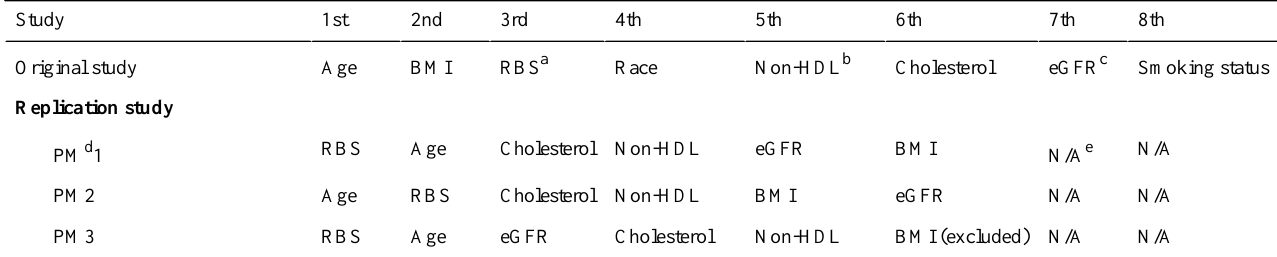
Table 4. Predictors importance rankings.